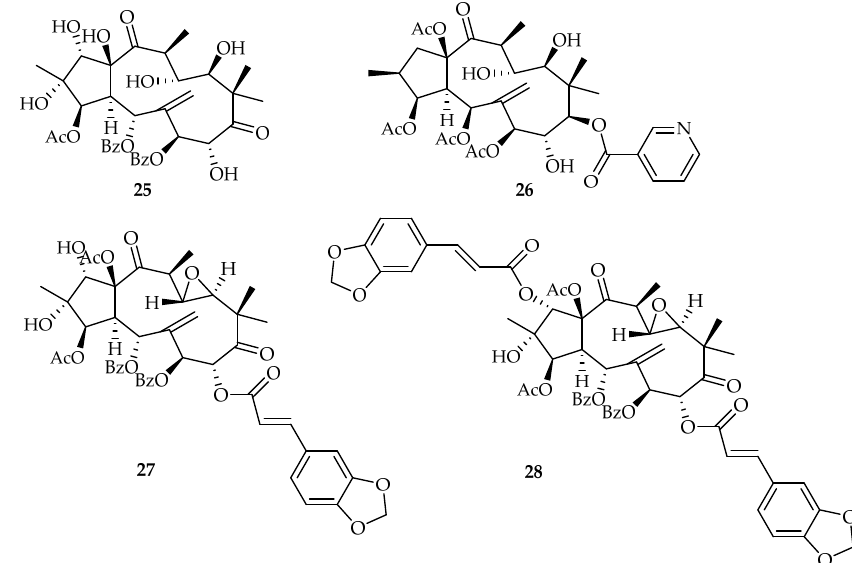
the range of 4.19–21.64 μM.